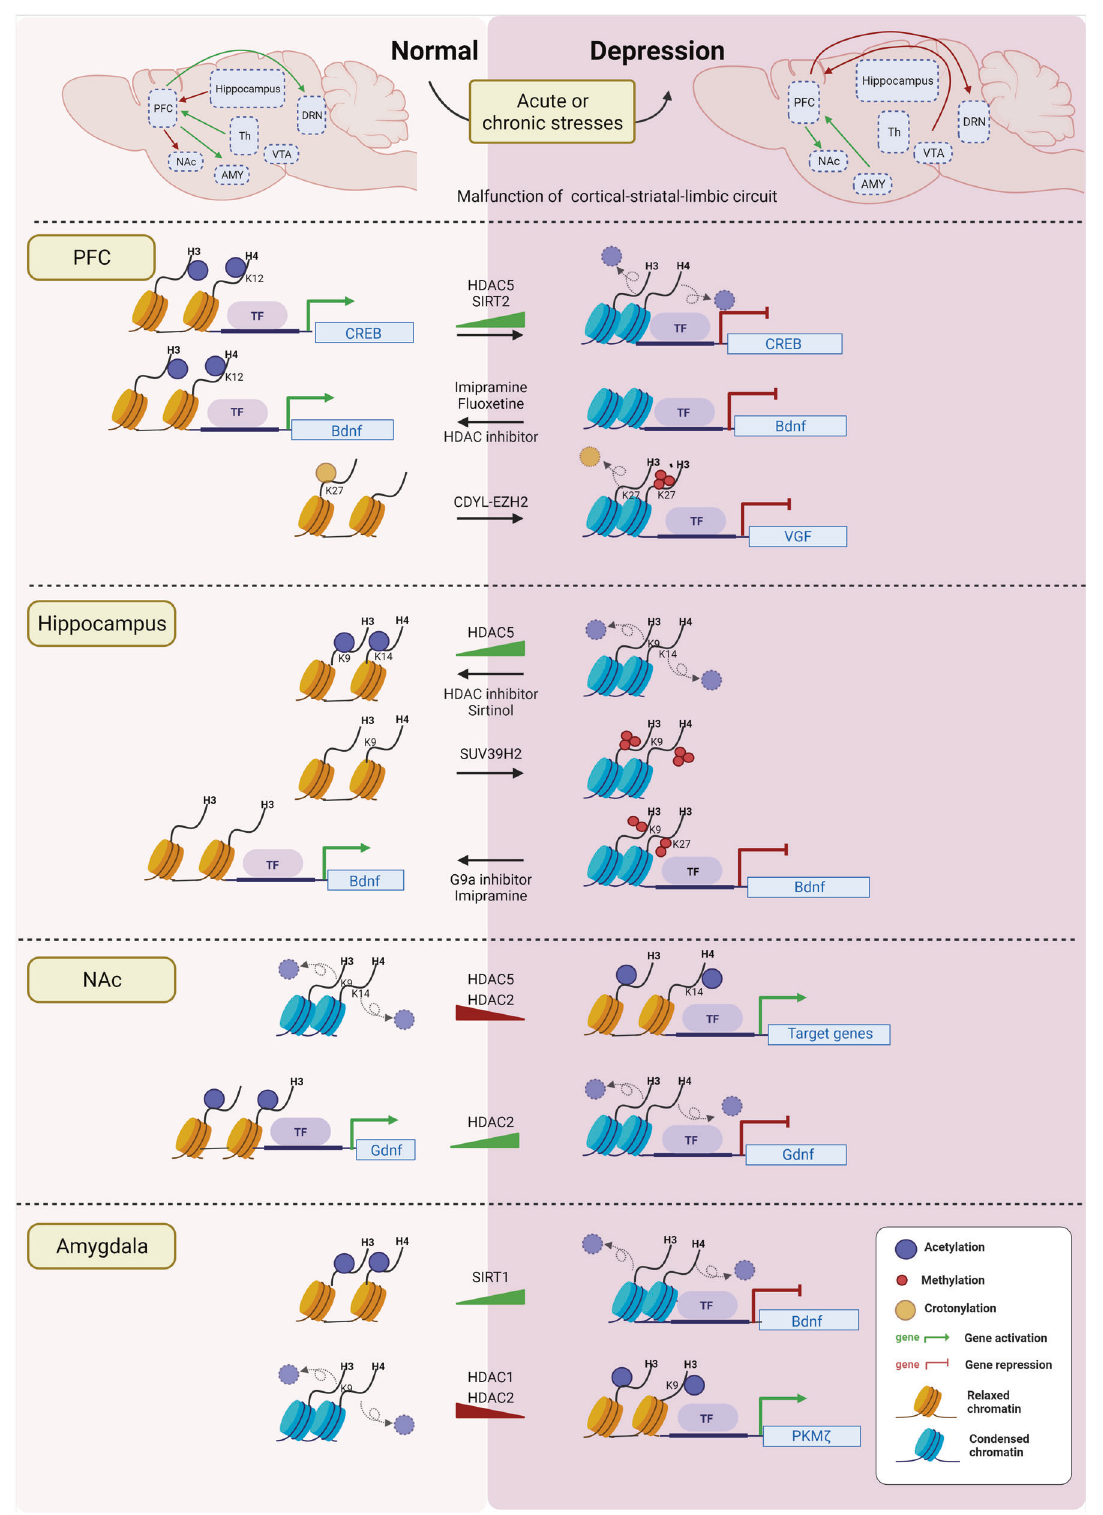
Fig. 9 Dysregulation of histone-modifying enzymes and histone modi fi cations in major depressive disorder (MDD). Neural circuit (cortical- striatal-limbic circuit) is structurally functionally disconnected in MDD. Histone modi fi cations in brain regions such as prefrontal cortex (PFC), hippocampus, nucleus accumbens (NAc), and amygdala are various. In general, repressive marks are increased in PFC and hippocampus. In NAc and amygdala, active or repressive histone marks are observed in the promoter regions